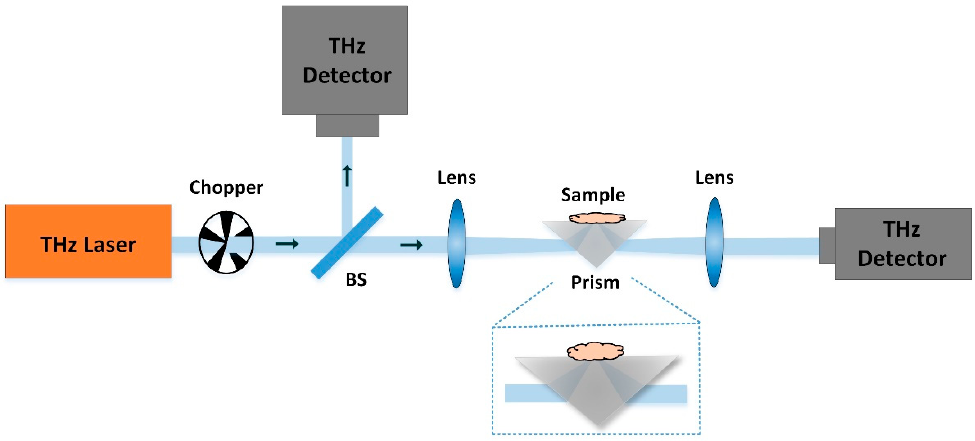
Figure 5. The setup of the CW THz ATR imaging scanning imaging